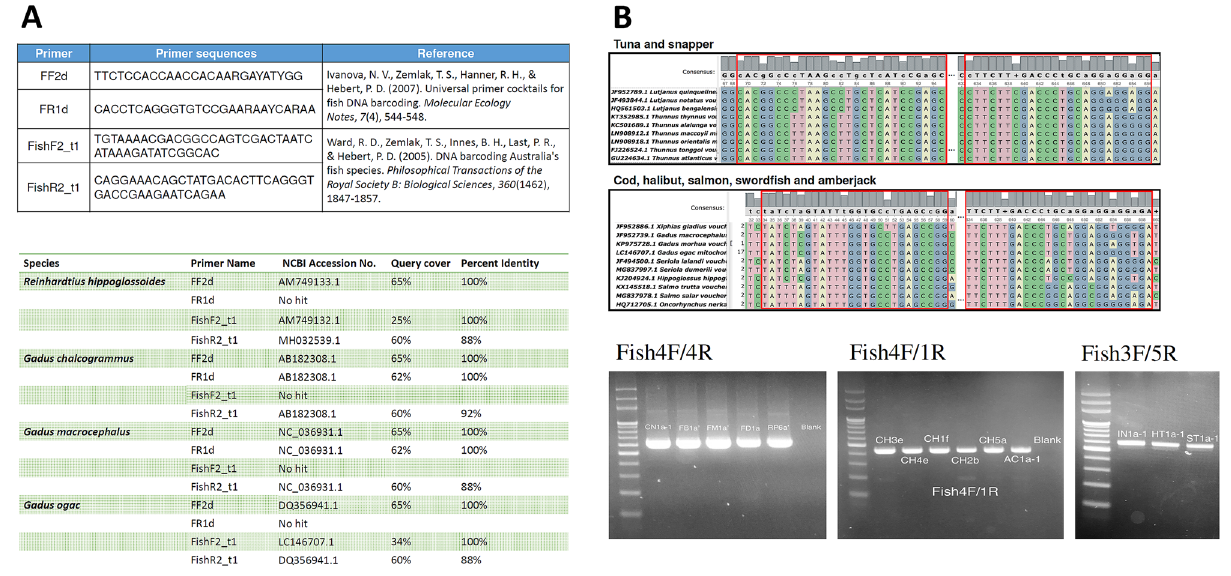
Figure 5. Primers for the fish taxonomic identification. ( A ) The primers in literature were aligned to reference sequences of Reinhardtius hippoglossoides, Gadus chalcogrammus, Gadus macrocephalus and Gadus ogacin in NCBI. These primers manifest poor query coverage (< 70%) to the fish species of interest in this study. ( B ) Primers and gel images of the amplified DNA. The primers Fish1R and Fish4F/4R were designed using the multiple sequence alignment of the reference sequences of cod, halibut, salmon, swordfish and amberjack. Fish3F and Fish5R were based on tuna and